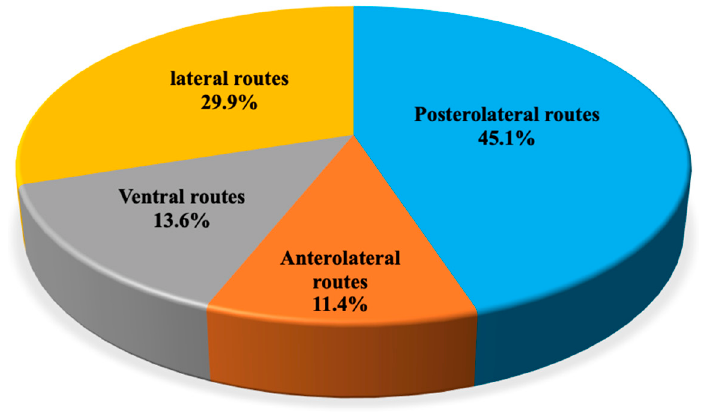
Figure 3. Distribution of papers addressing petroclival meningiomas divided per surgical corridor. Cavernous sinus meningiomas (CSMs) are discussed by 25 papers proposing man- agement based upon transcranial anterolateral (12 papers, 48%), lateral routes (6 articles, 24%), and ventral corridors (7 articles, 28%); the current policy counts on the debulking of the intracavernous aspects of the lesion and the removal of the outer portion, along with bony decompression. Both transcranial and transsphenoidal surgery provide similar and promising results (Figure 4).